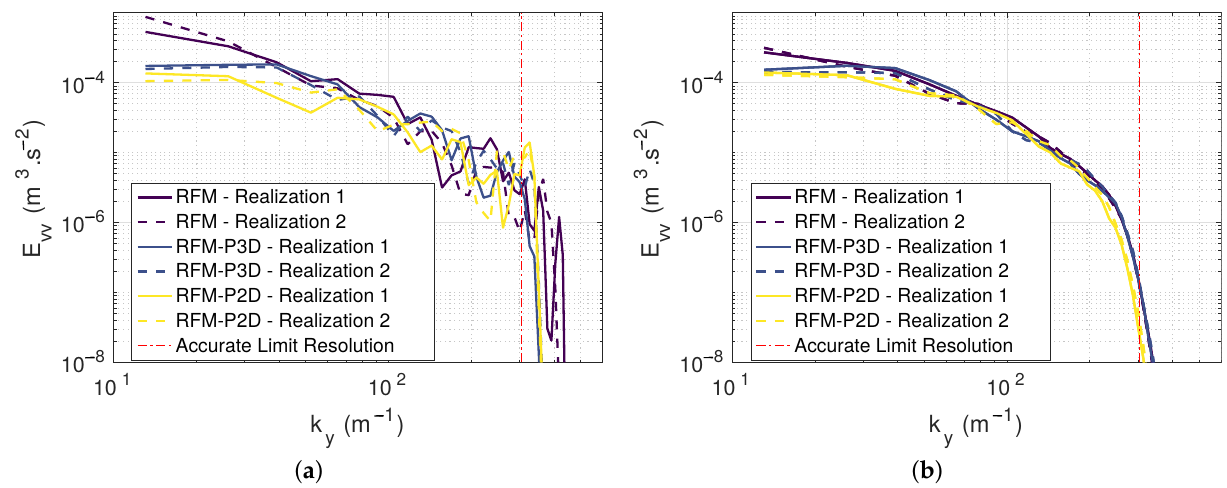
Figure 12. One-dimensional spectra for the Single Grid configuration and two different turbulence realizations at ( a ) x = 0 and ( b ) x = 90 Λ f . CBC curve represents the Comte-Bellot and Corrsin experiment results [40] on their first measurement plane.